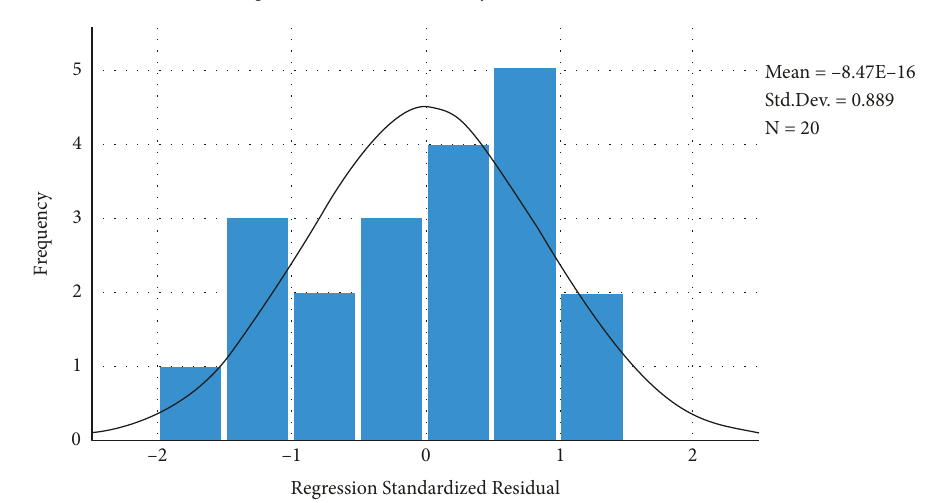
Figure 8: Histogram representation of regression